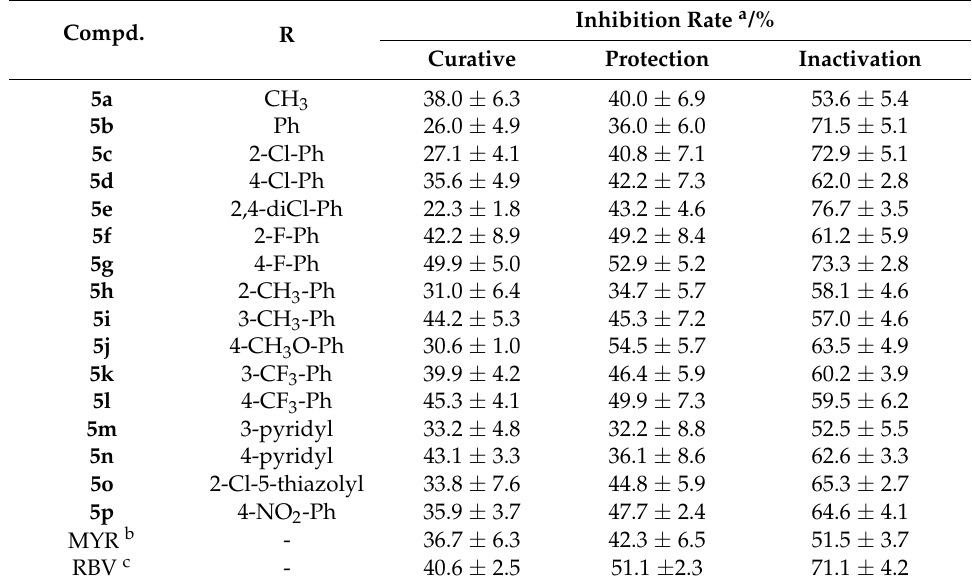
Table 3. Antiviral activities of the test compounds against TMV in vivo at 500 µ g/mL.